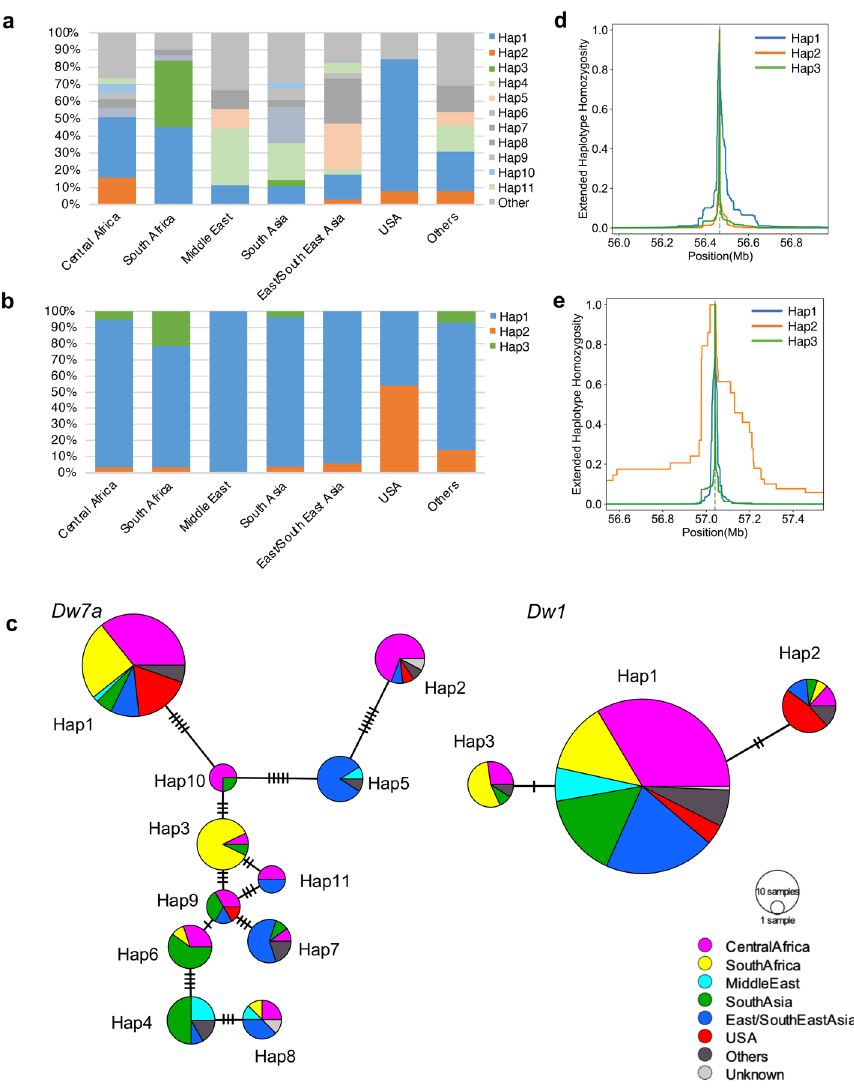
Figure 6. Haplotype analyses of Dw7a and Dw1 . ( a , b ) Regional distribution of each haplotype of the Dw7a ( a ) and Dw1 ( b ). ( c ) Haplotype network of Dw7a and Dw1 using 187 accessions. Hatch marks between each haplotype indicate the mutational step. In Dw7a , Hap1 to Hap11 were used for analysis (147 accessions). ( d , e ) Extended haplotype homozygosity (EHH) decay of Dw7a ( d ) and Dw1 ( e ). Hap1 (blue), Hap2 (orange), and Hap3 (green) are shown. Dotted lines indicate the positions of Dw7a ( d ) and Dw1 ( e